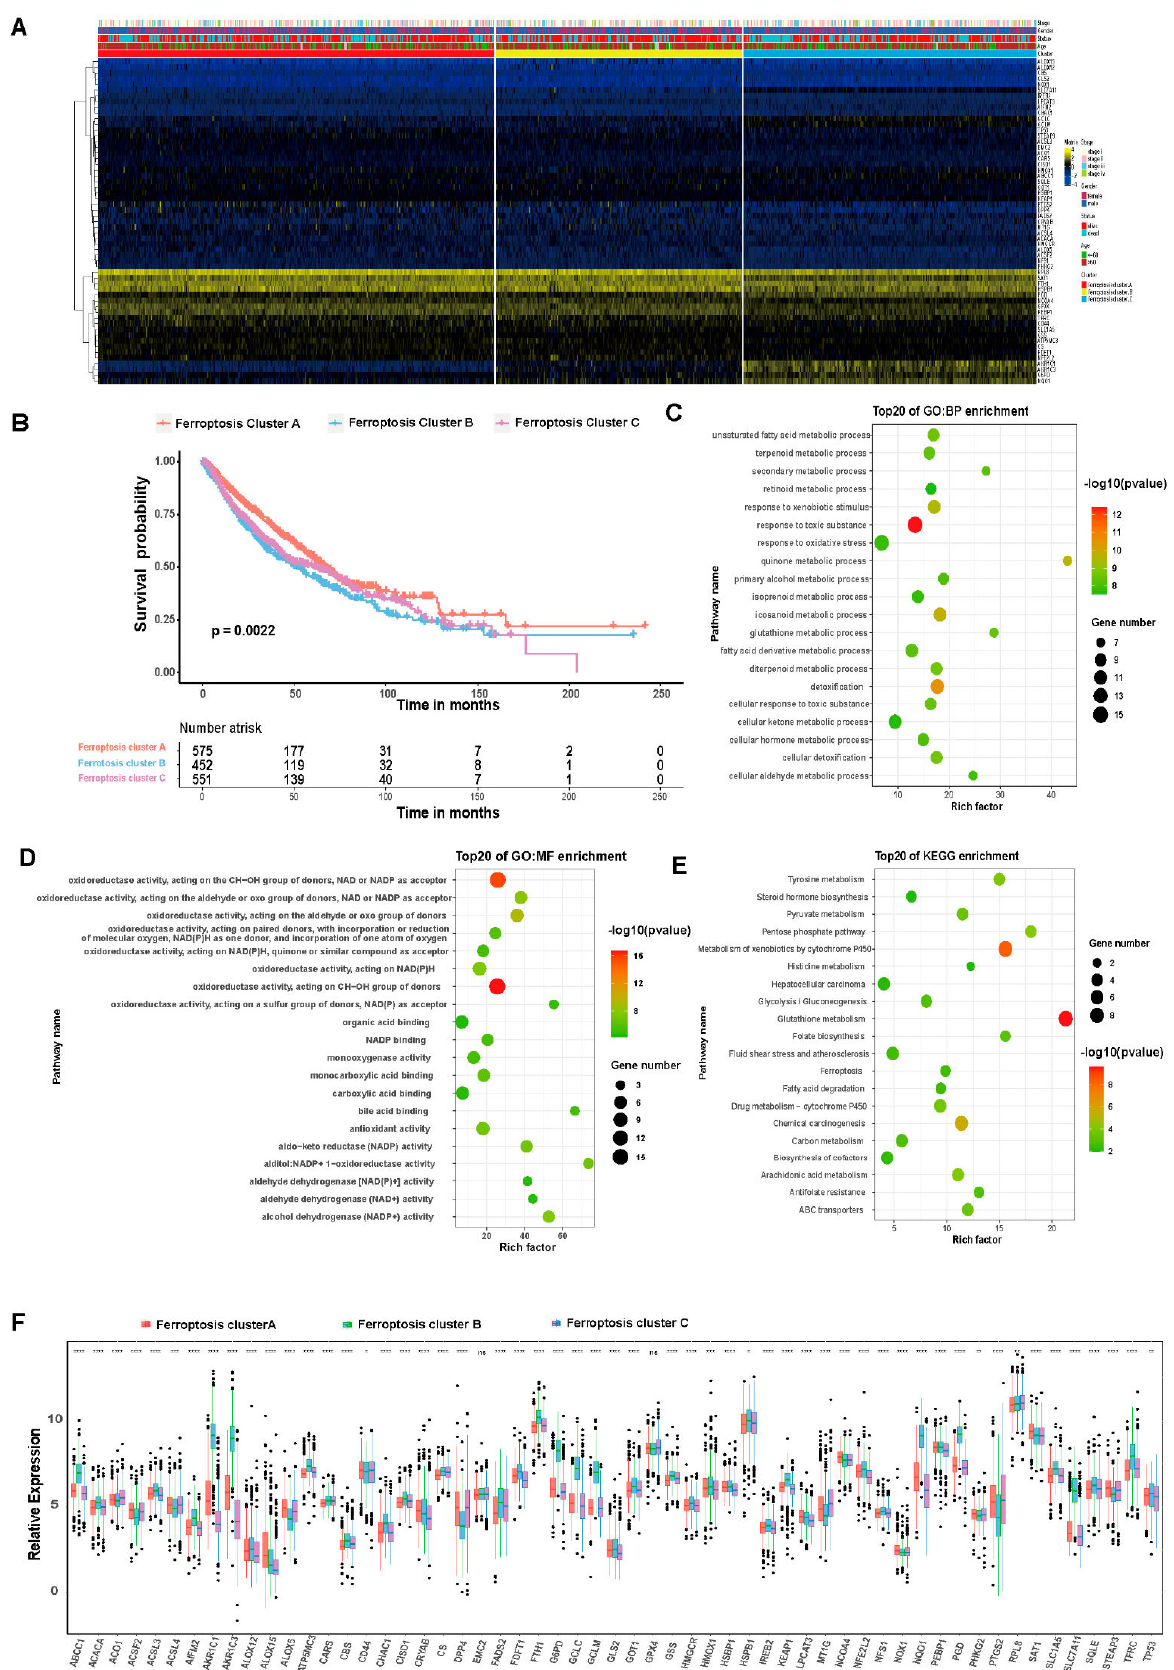
Figure 5. Comparison between ferroptosis-related gene cluster groups. ( A ) Unsupervised